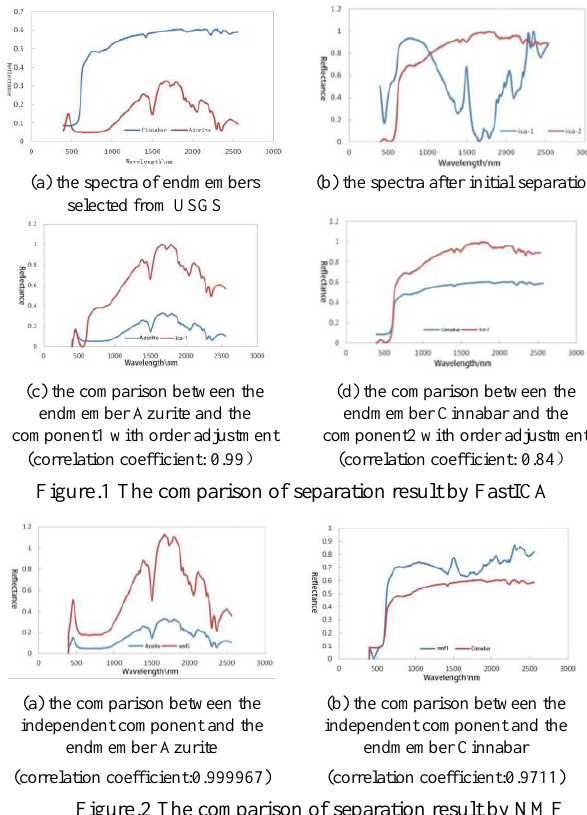
Figure.2 The comparison of separation result by NMF